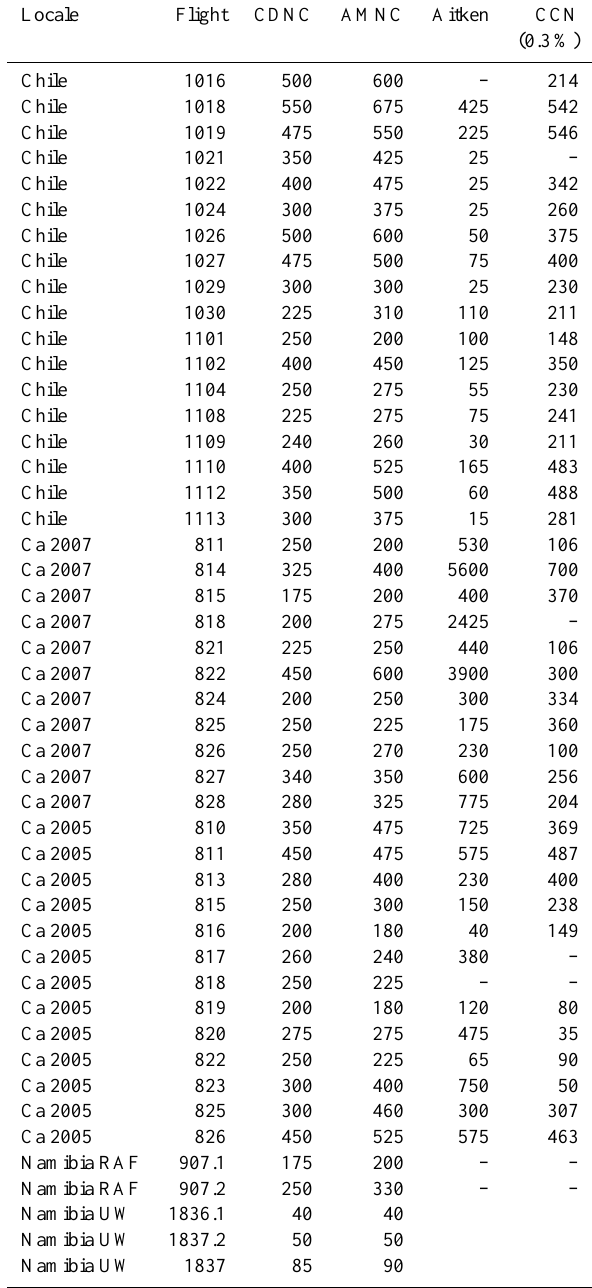
Table 1. Values of the variables used in the analysis derived from the vertical profiles through the cloud decks in the three regions ex- amined. Note that UW denotes data from the University of Wash- ington archive (see text) while RAF denotes data from Kiel and Haywood